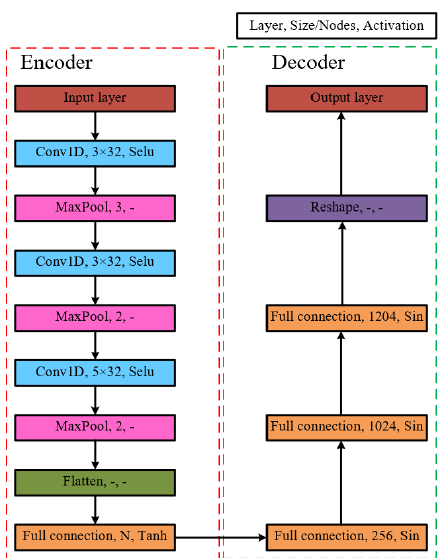
Figure 5. Detailed architecture of 1D−CAE in AOU−1D−CAE−APSO.